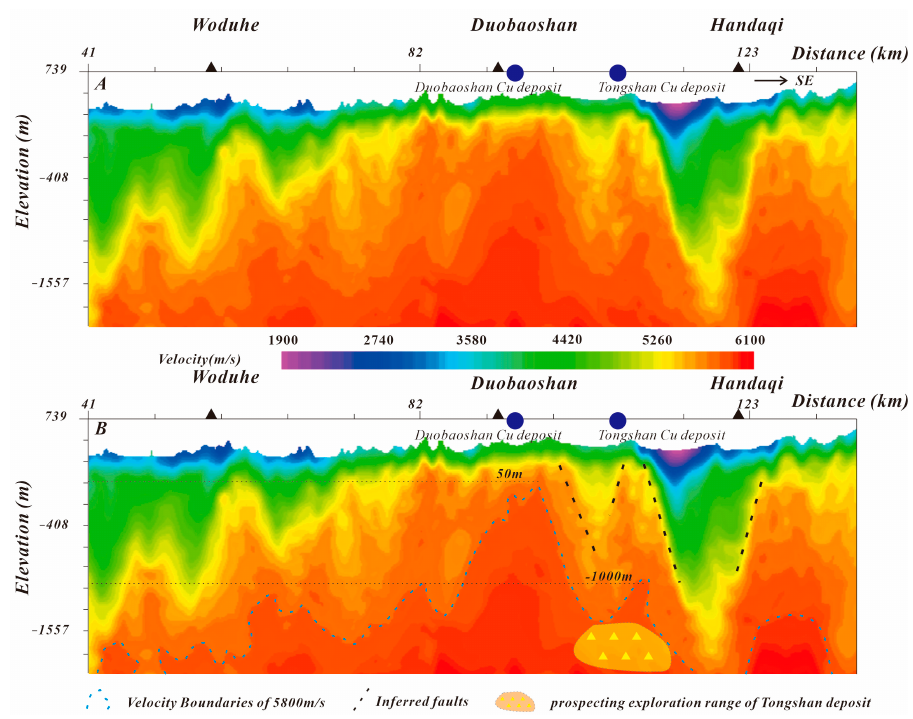
Figure 10. Velocity profile of the Tongshan and Duobaoshan porphyry Cu ‐ Mo ‐ (Au) deposits. ( A ) Velocity profile of first ‐ arrival seismic tomography inversion ( B ) Interpretation of velocity structure.